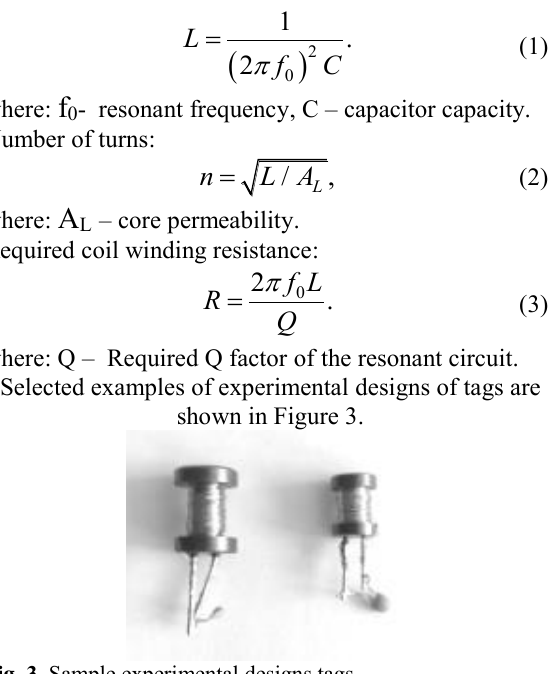
Fig. 3. Sample experimental designs tags.